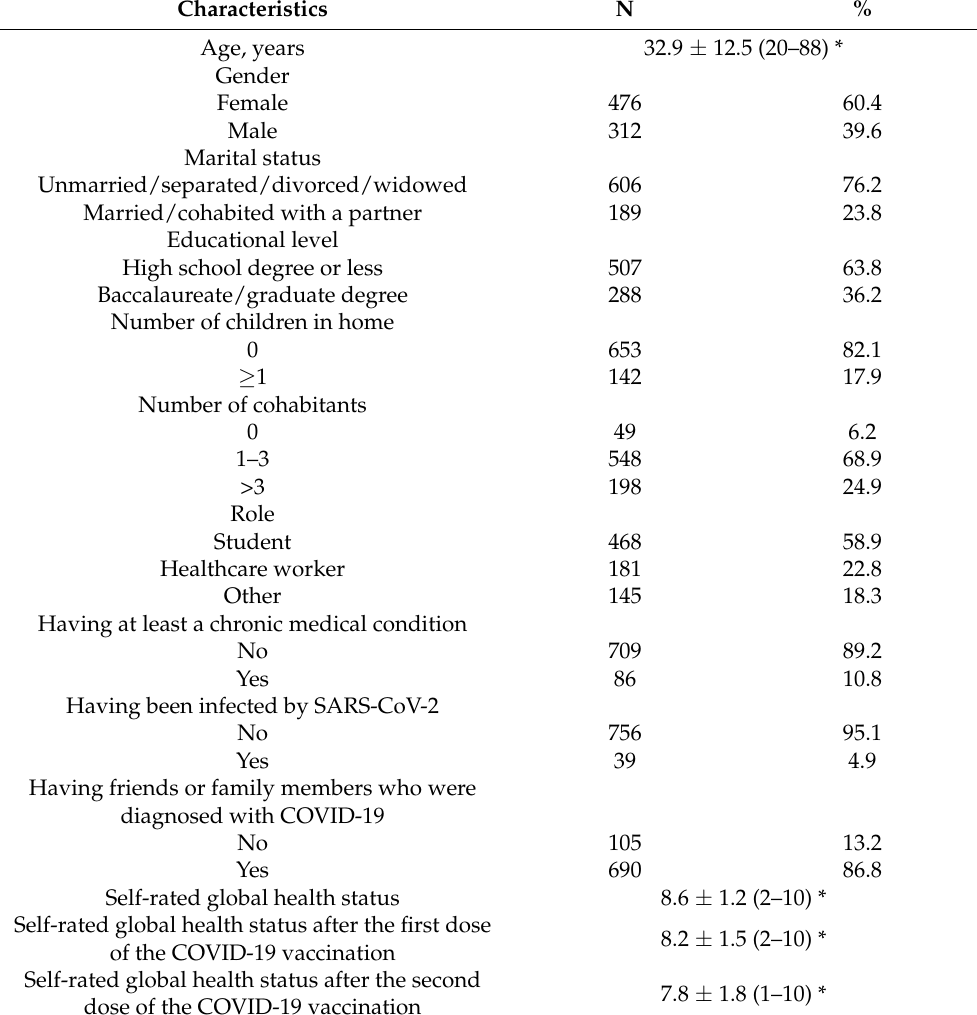
Table 1. Socio-demographic and key characteristics of the study population.